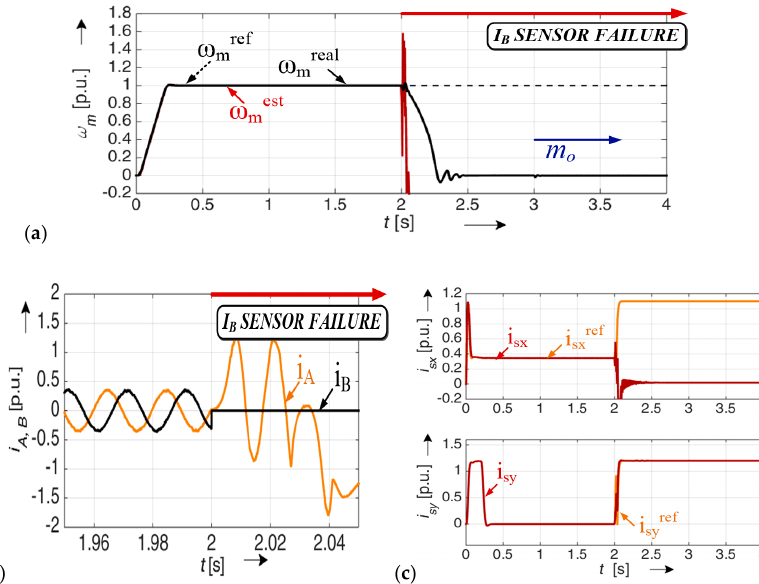
Figure 5. Results for the drive system with a broken current sensor in phase B (lack of signal), (rotor speed ( a ), stator current ( b ), stator current components x,y ( c )) , i B’ =